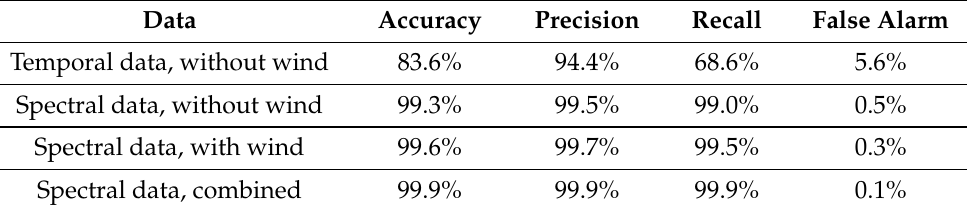
Table 1. Summary of the ANN’s performance for the various environmental conditions.